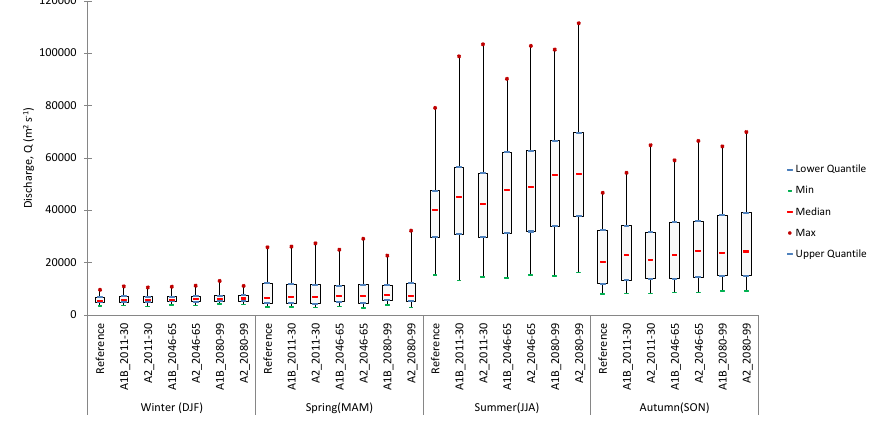
Fig. 4. Box plots of stream flow for different seasons and for different time slices. Box plot represents the multi-model weighted variation over the